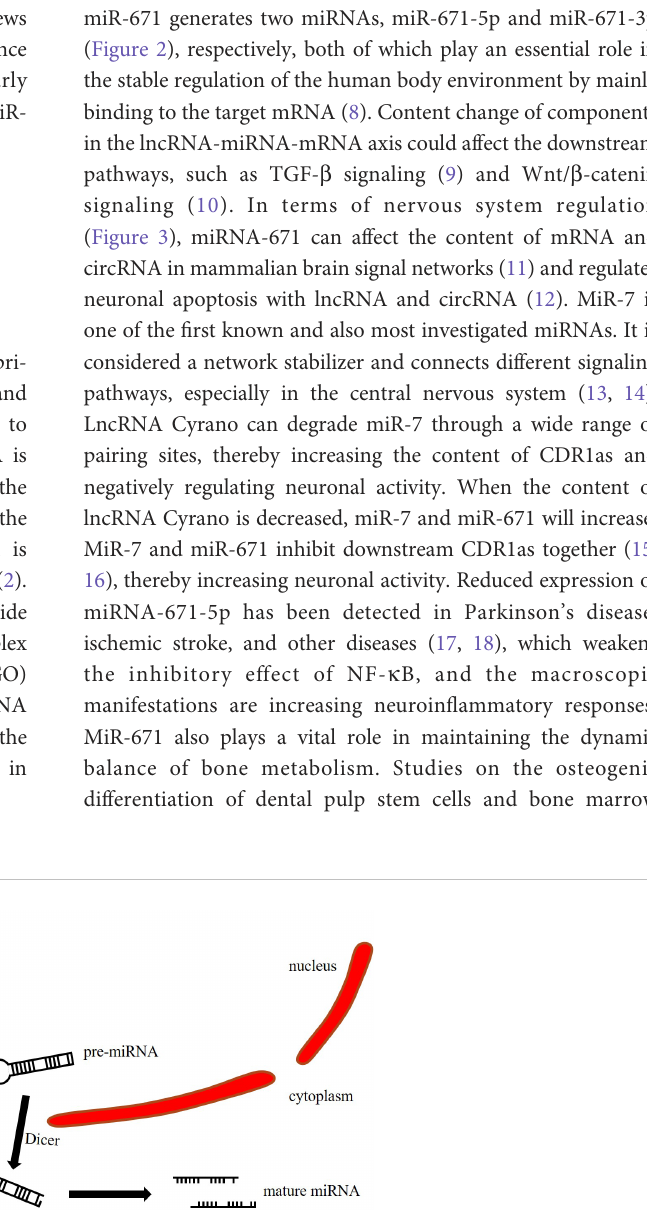
FIGURE 1 miRNA maturation process.